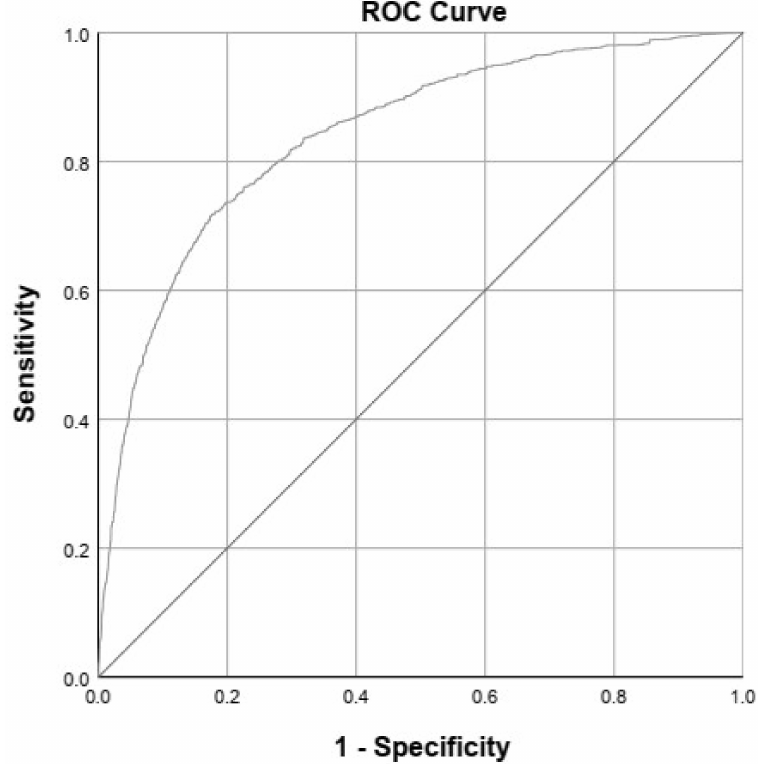
Figure 1. Receiver operating characteristic (ROC) curve after correction for optimism over the 10 imputed datasets (area under the curve =